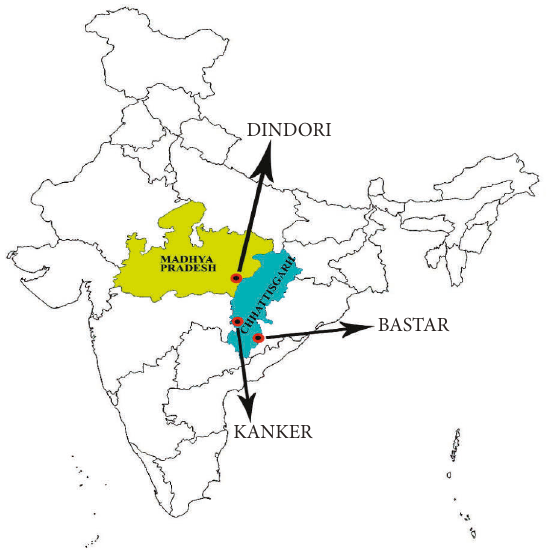
Figure 1: Map of India showing the location of the study district Dindori in Madhya Pradesh state and districts Kanker and Bastar in Chhattisgarh